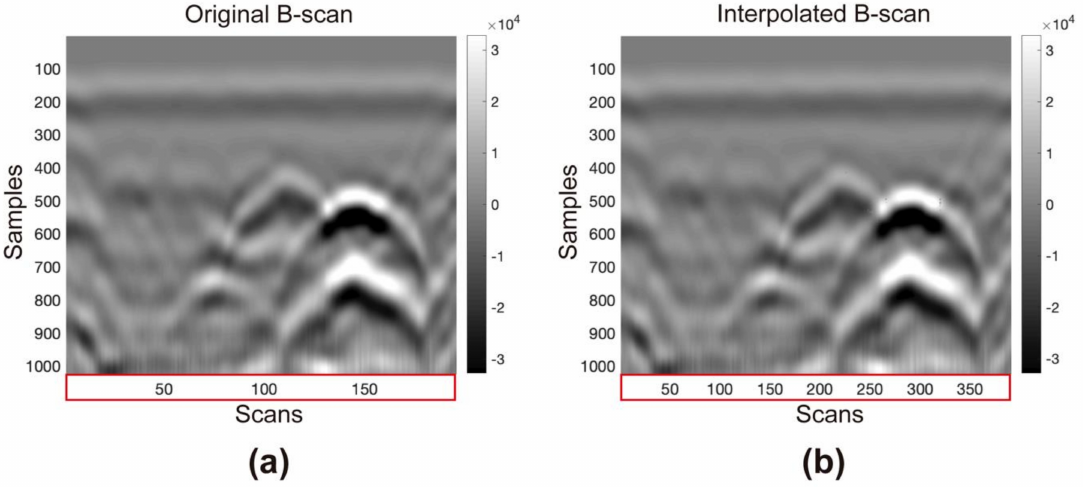
Figure 4. ( a ) Input B-scan. ( b ) Output B-scan after applying the Fourier interpolation through the Suinterp algorithm. There is no change in the initial data other than a slight increase in